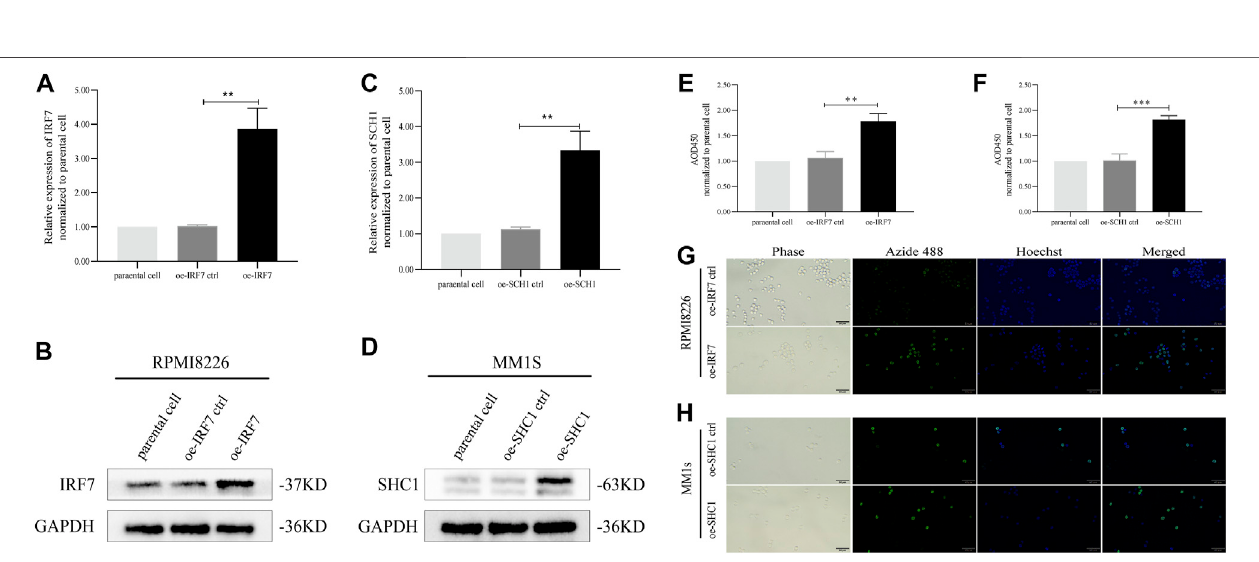
FIGURE9| IRF7,SHC1promotetumorcellproliferation. (A – D) qPCRexperimentandWesternBlotexperimenttodetecttheexpressionofIRF7andSHC1. (E – H) CCK8 immuno fl uorescence staining and EDU test to detect the proliferation of tumor cells in the experiment and the control group MM. Protein expression was determined by western blotting and representative results from one of the three independent experiments are presented. Bar graphs were average of experimental replicates from three independent experiments. Error bars represent mean ± s.d.; ** p < 0.01; *** p < 0.001; by unpaired two-sided Student ’ s t-test.